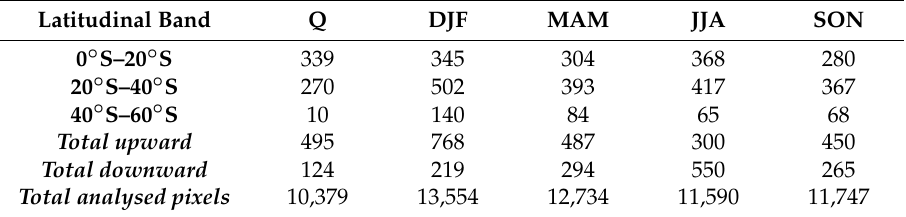
Table 3. As in Table 1 but for the SO 2 concentrations in the